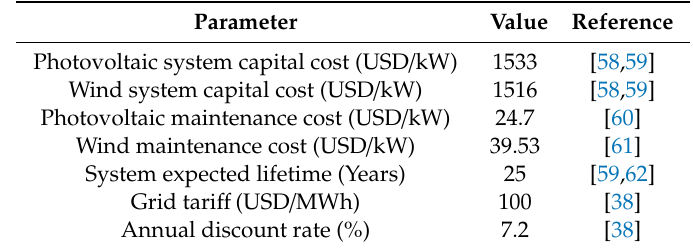
Table 1. The photovoltaic (PV) and wind systems economic parameters and the grid tari ff in addition to the yearly discount rate for Gwanda city,